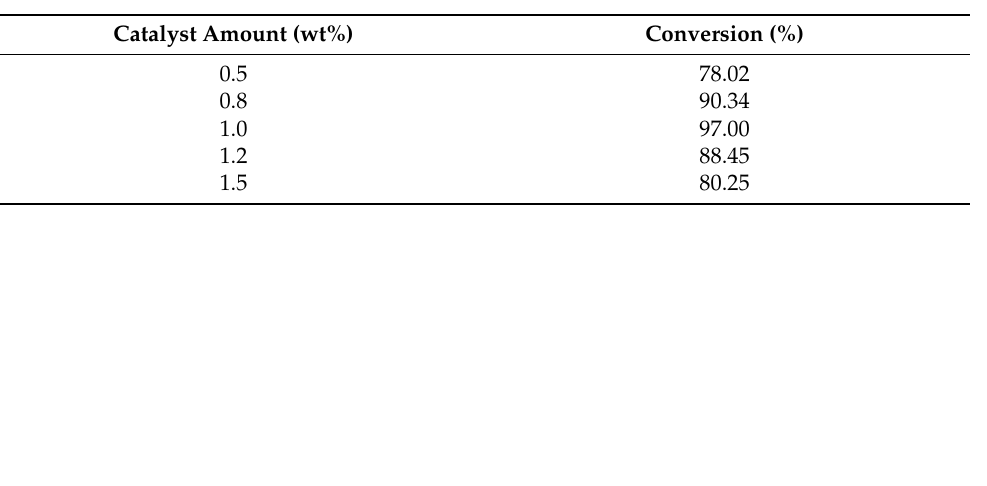
Table 2. Effect of catalyst amount on the biodiesel